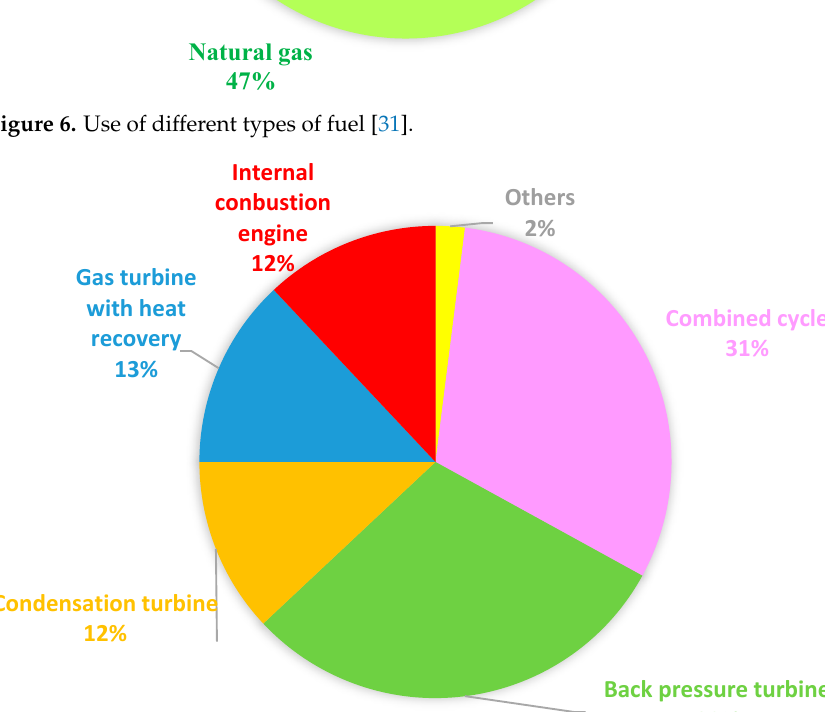
Figure 7. Electricity production distribution among different CHP systems in EU [31].